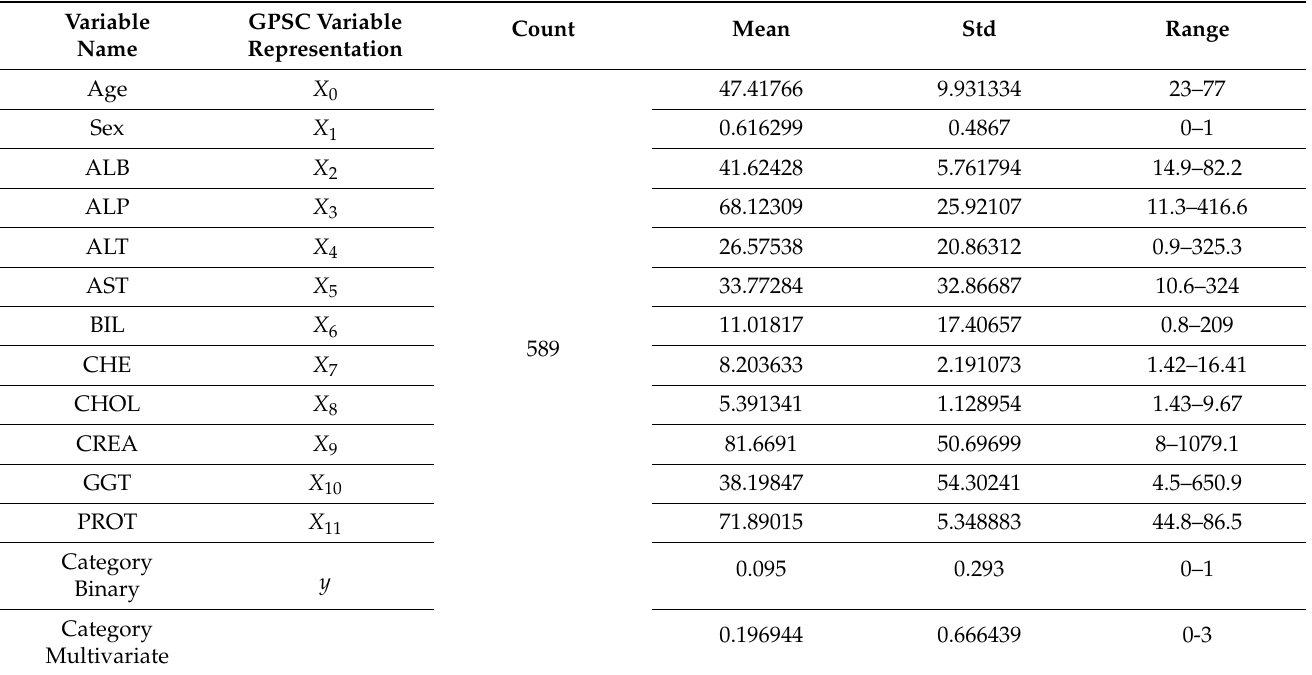
Table 1. Results of statistical analysis of the dataset with definition of input and output dataset